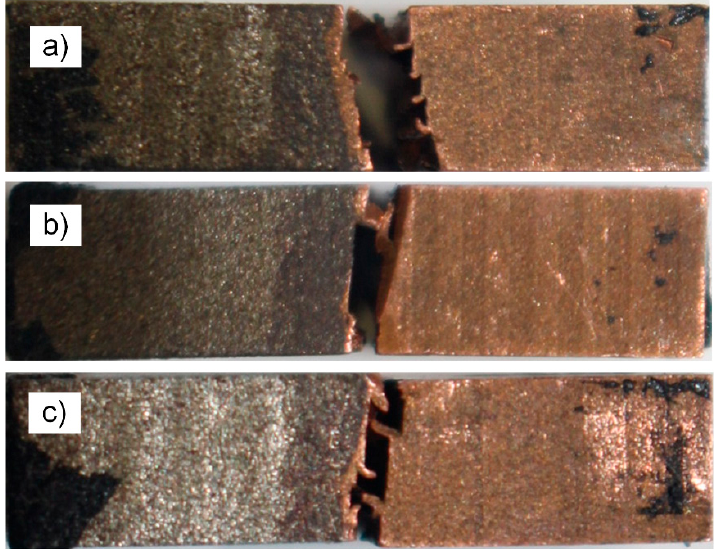
Figure 7. Macroscopic tensile fracture ( a ) for specimen 1; ( b ) for specimen 2; and, ( c ) for specimen 3; steel on the left and copper on the right.